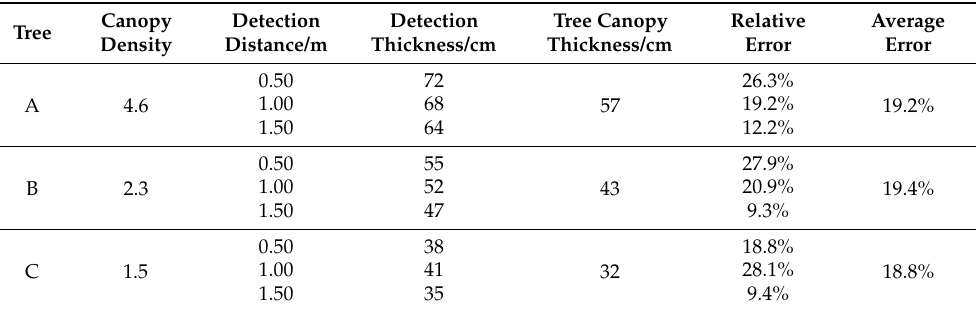
Figure 11. Tree A, Tree B, and Tree C canopy detection experiments. The results of the tree canopy thickness detection are shown in Table 8. Table 8. Results of tree canopy thickness experiments.